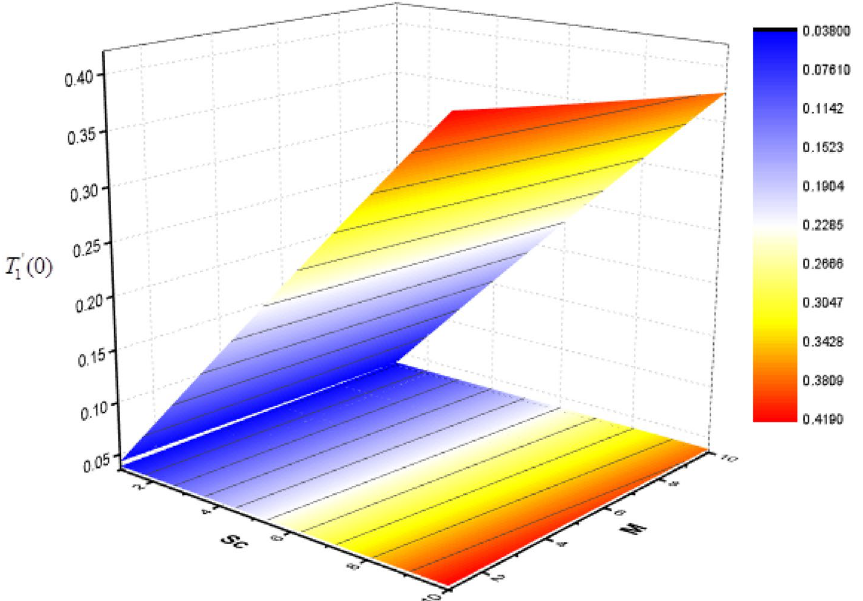
Figure 25. Consequence of Sc and M on T ′ 1 ( 0 )